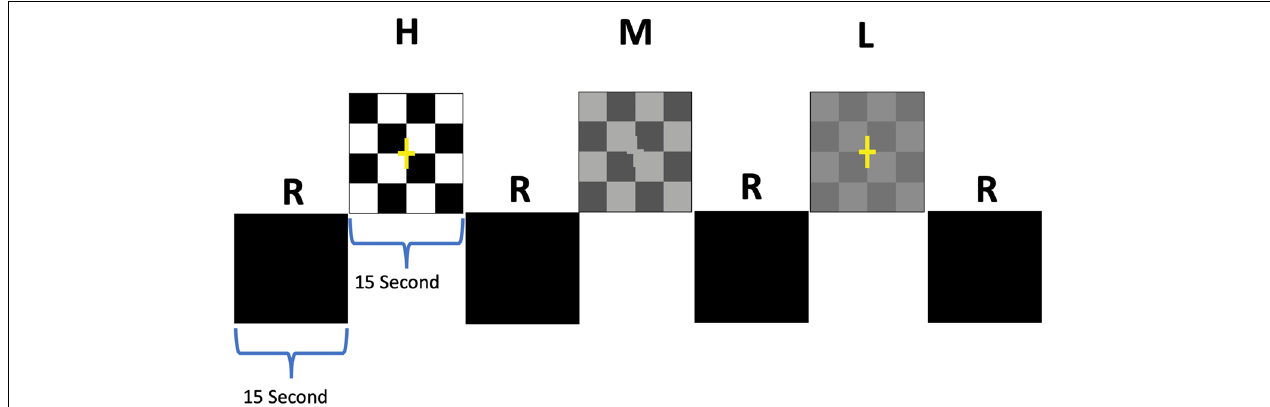
FIGURE 2 | Schematic block diagram of the visual stimuli. The checkerboard paradigm consisted of 15 s active blocks of contrast-reversing (8 Hz) checkerboards interleaved with 15 s presentation of a blank screen as rest blocks (R). Active blocks were comprised of 3 blocks for each contrast that were randomly presented for high (H), medium (M), and low (L) contrasts interspersed with 9 rest blocks (Ashtari et al., 2011).